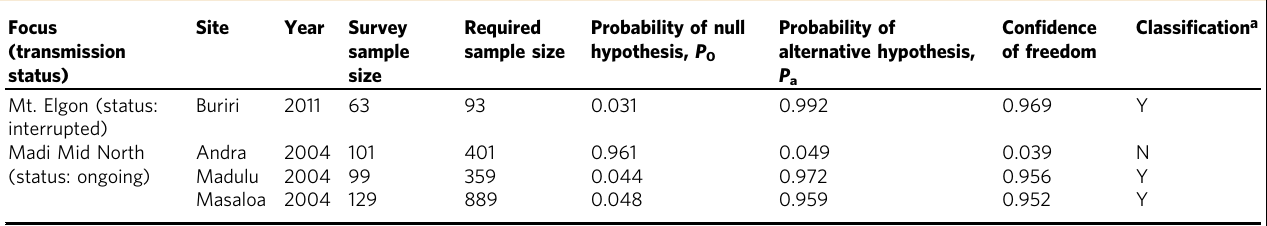
Table 5 Required sample sizes and corresponding PFFI classi fi